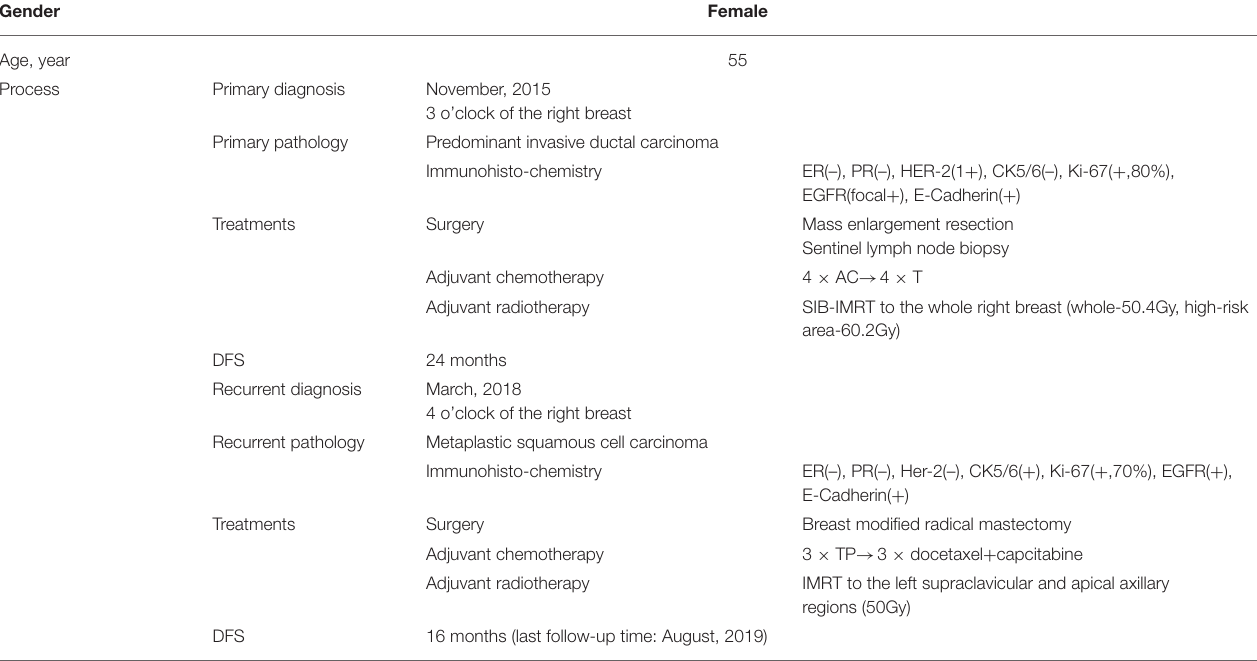
TABLE 1 | The patient’s characteristics and treatment